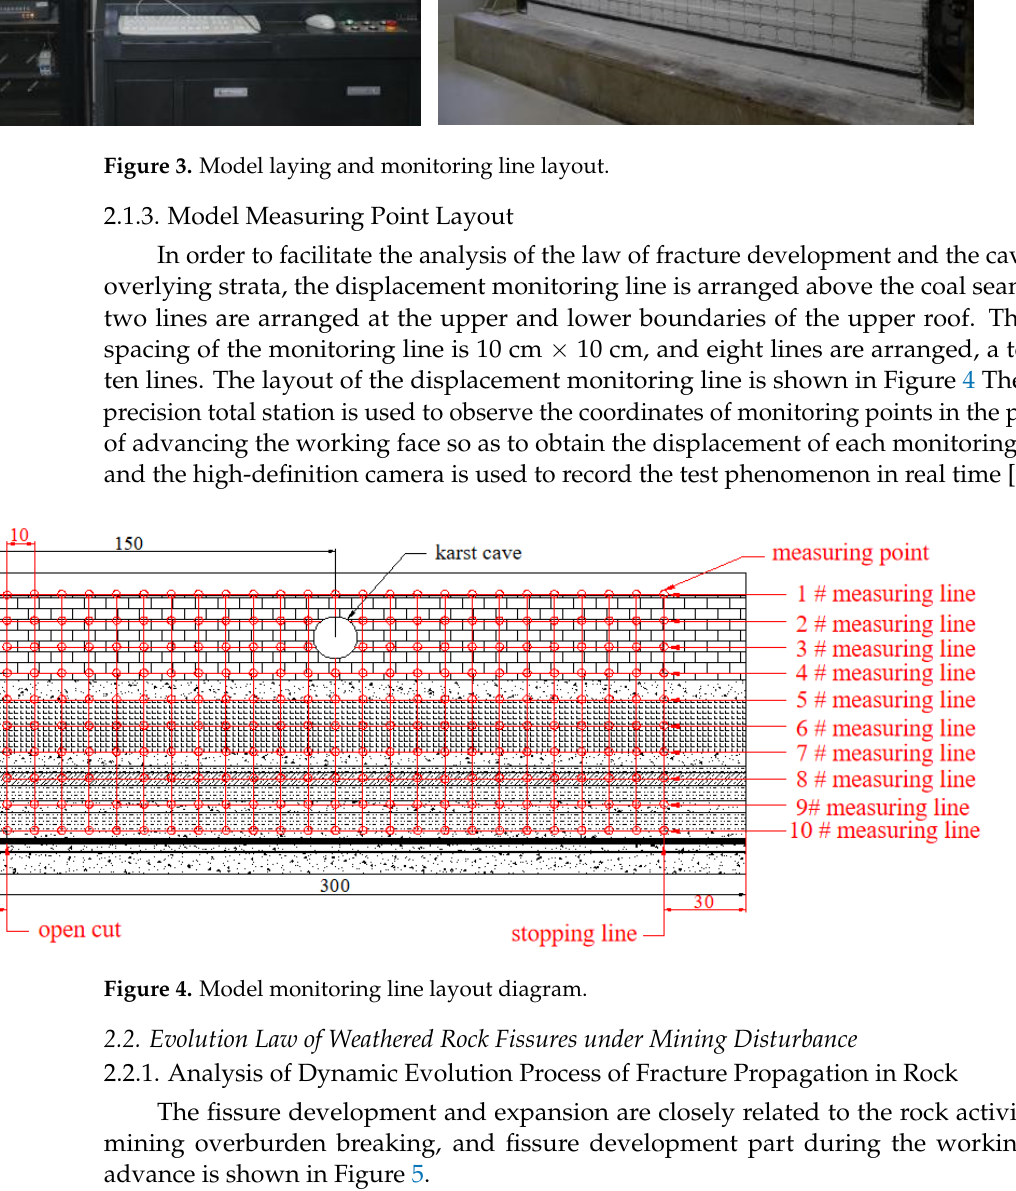
Figure 4. Model monitoring line layout diagram.